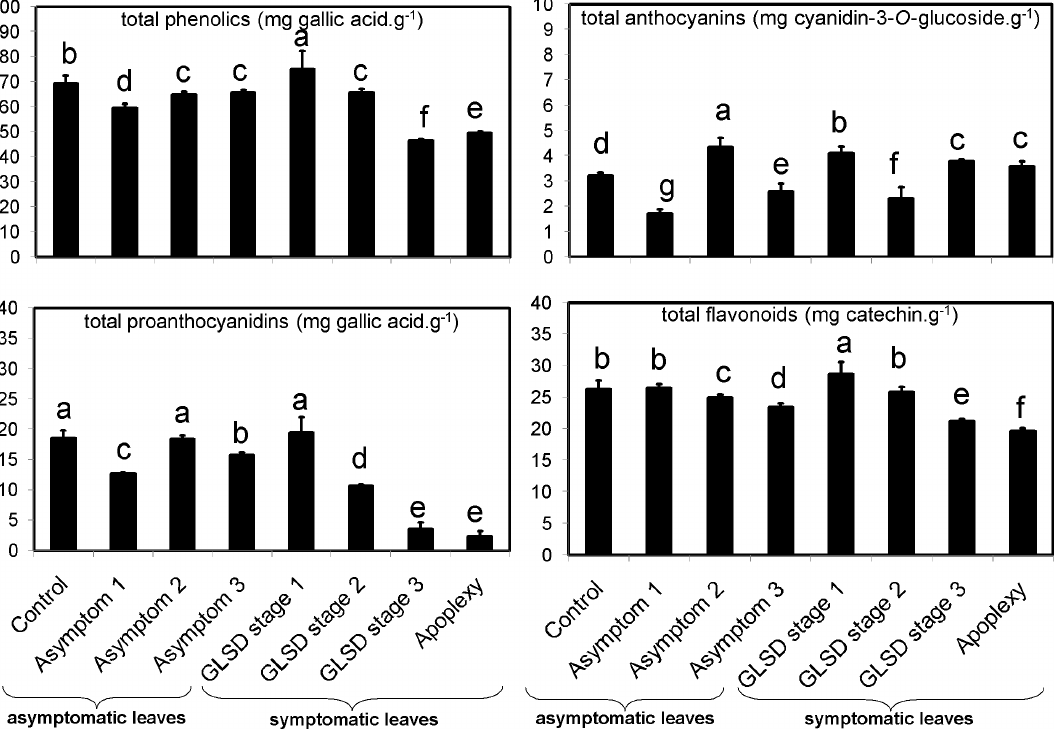
Figure 1. Total phenolic (TPC), anthocyanin (TAC), proanthocyanidin (TPAC), and flavonoid (TFC) content (dry weight basis) in asymptomatic and symptomatic leaves of vines affected by brown wood streaking, grapevine leaf stripe and apoplexy. The legend is as in Figure 6. Error bars = standard deviations ( n = 4); different letters above the columns denote statistical differences (Tukey’s test; P ≤ 0.05).